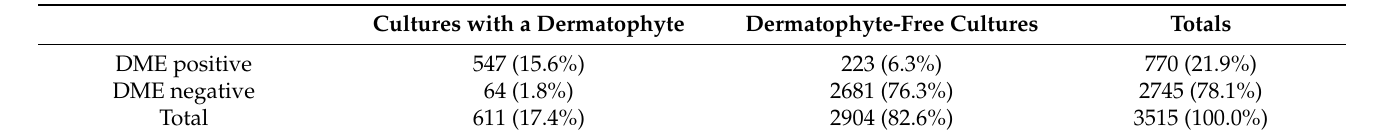
Table 1. Analysis of animal samples at the CHUV from 2008 to 2022 for the detection and identification of dermatophytes.